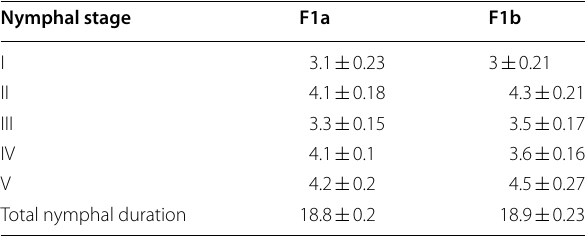
Table 2 Nymphal duration of F1 generation of Blaptostethus pallescens obtained from the parent bugs fed on Vl-8 treated and untreated thrips